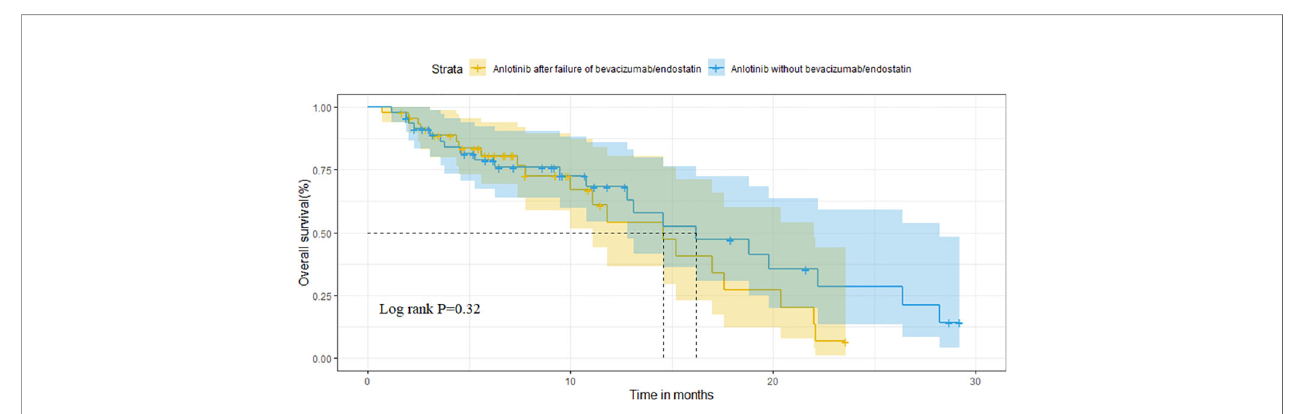
FIGURE 4 | Comparison of OS between the two groups after